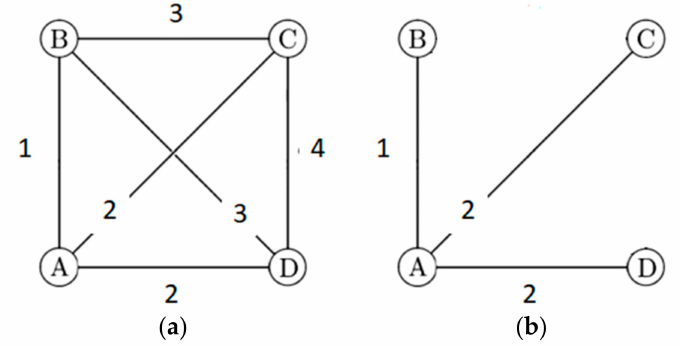
Figure 2. ( a ) Connected graph G and ( b ) minimum spanning tree for